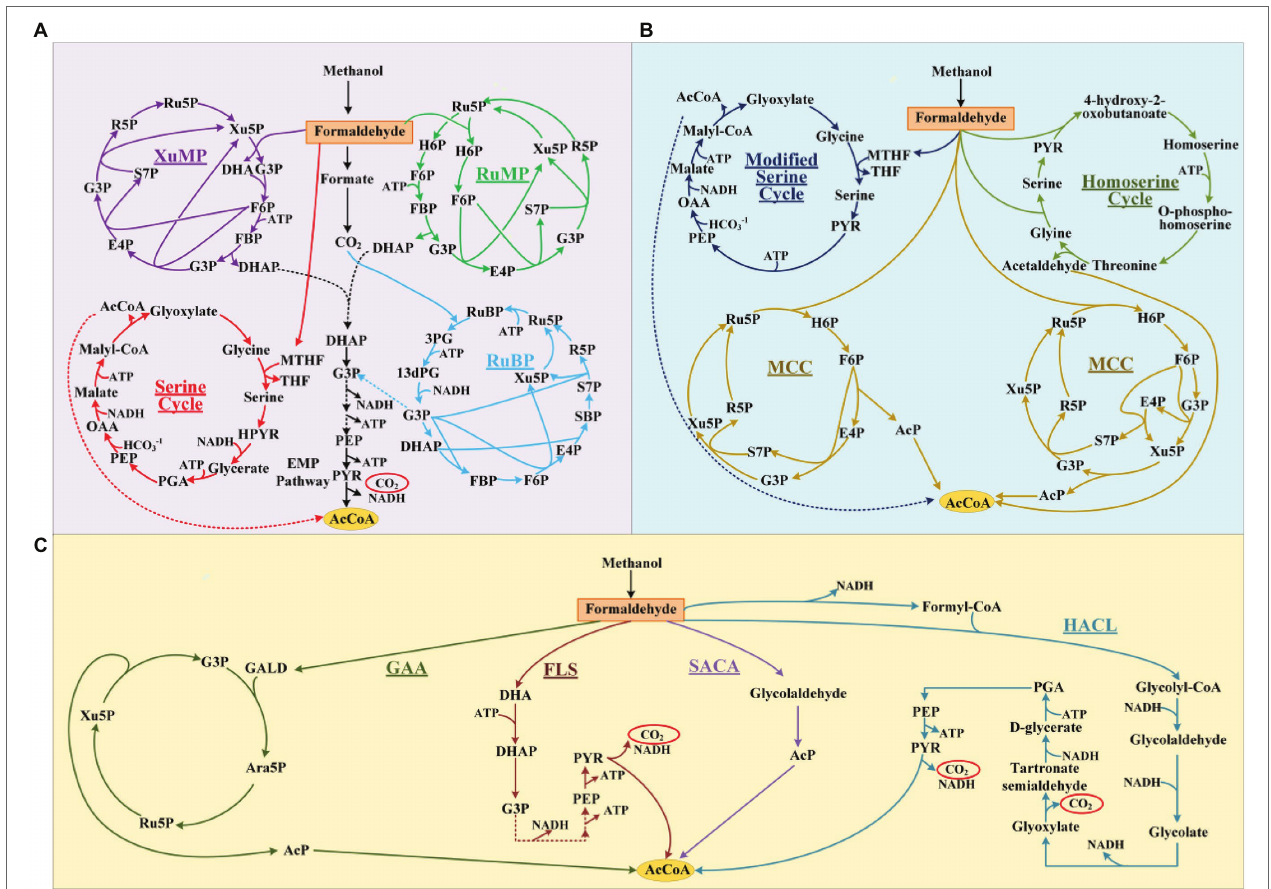
FIGURE 1 | Methanol assimilation pathways. The natural pathways (A) and artificial pathways without non-natural reactions (B) or artificial pathways based on non- natural reactions (C) . R5P, D-ribose 5-phosphate; Ru5P, D-ribulose 5-phosphate; Xu5P, D-xylulose 5-phosphate; DHA, dihydroxyacetone; G3P, D-glyceraldehyde 3-phosphate; F6P, D-fructose 6-phosphate; FBP, fructose 1,6-bisphosphate; E4P, D-erythrose 4-phosphate; H6P, D-hexulose 6-phosphate; S7P, D-sedoheptulose 7-phosphate; SBP, D-sedoheptulose 1,7-bisphosphate; DHAP, dihydroxyacetone phosphate; PEP, phosphoenolpyruvate; PYR, pyruvate; RuBP, D-ribulose 1,5-bisphosphate; 3PG, D-glycerate 3-phosphosphate; 13dPG, 3-phospho-D-glyceroyl phosphate; OAA, oxaloacetate; GALD, glycolaldehyde; Ara5P, D-arabinose 5-phosphate; PGA, D-glycerate 2-phosphate; AcP, acetyl-phosphate; and AcCoA, acetyl-coenzyme